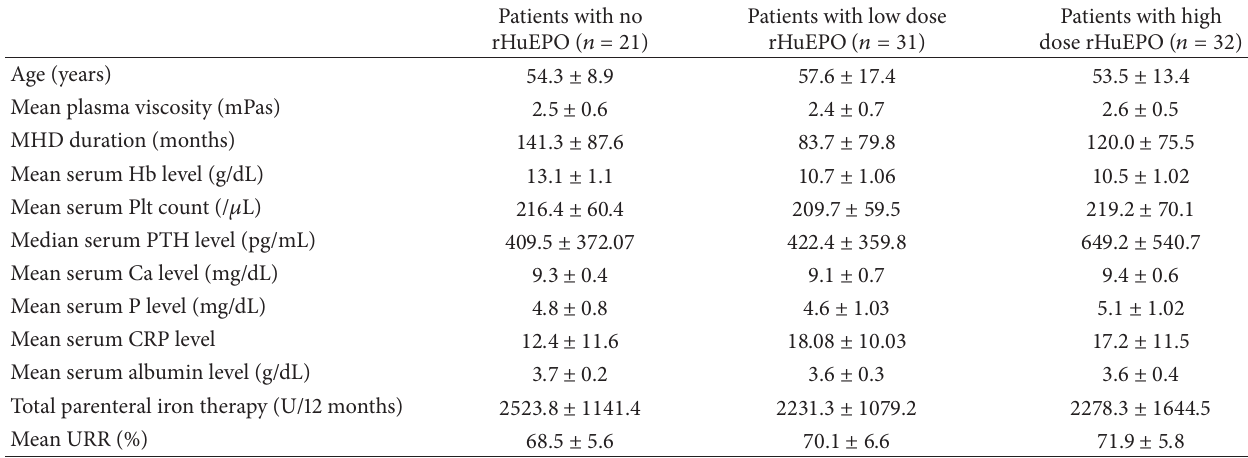
Table 4: Demographic and biochemical characteristics of the study